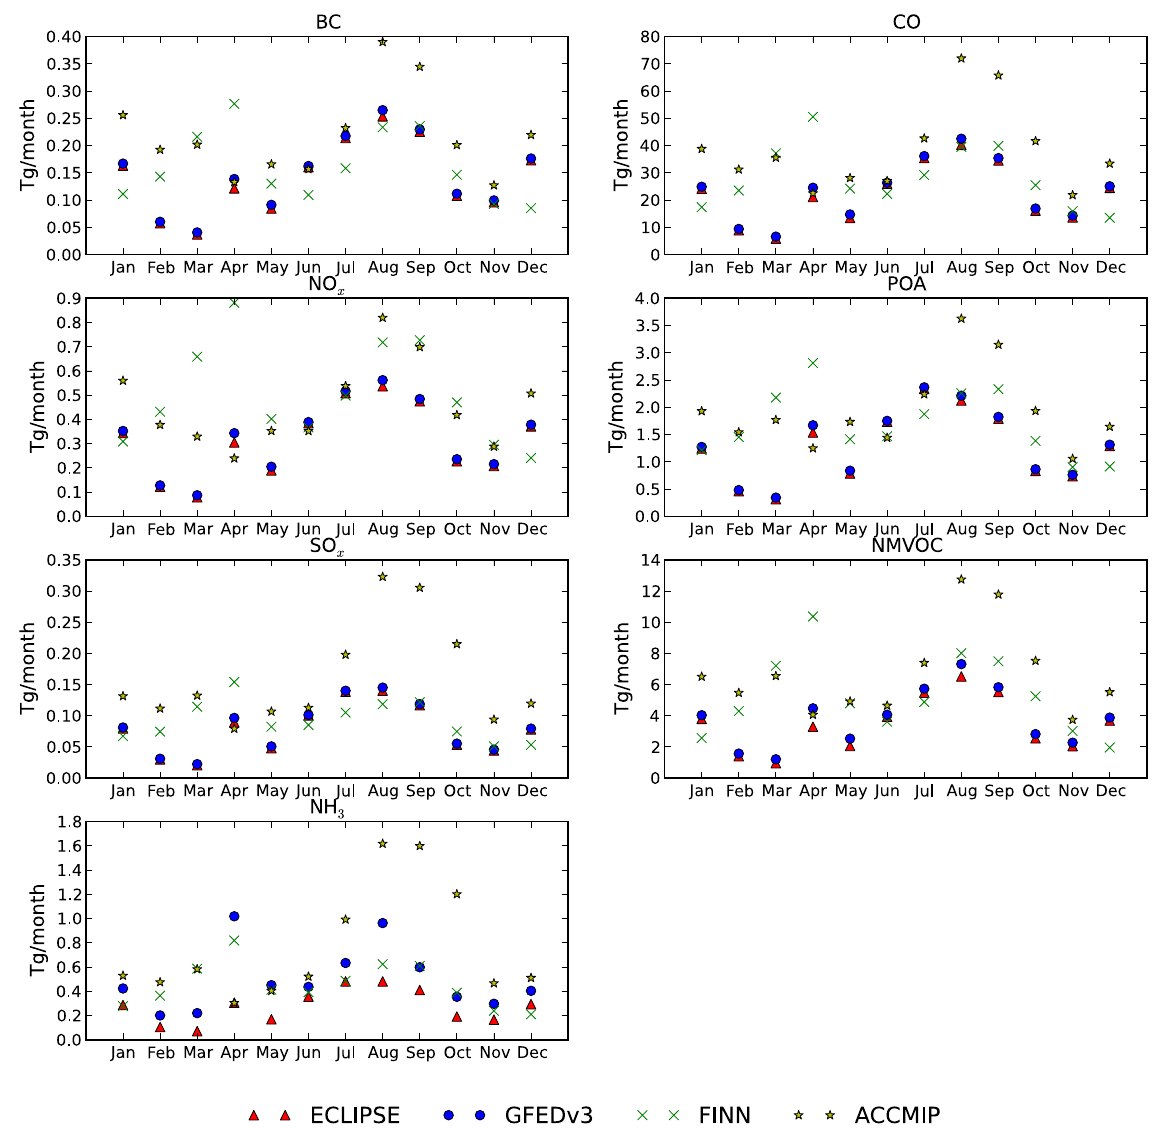
Figure 1. Monthly variation and differences of biomass burning emission inventories for the year 2008 for all species used in the model. For simplicity, NMVOCs are summed. NO x are presented in NO, SO x in SO 2 and NMVOCs in total mass. Table 5. Total annual mean tropospheric load of pollutants for all simulations (in Tga − 1